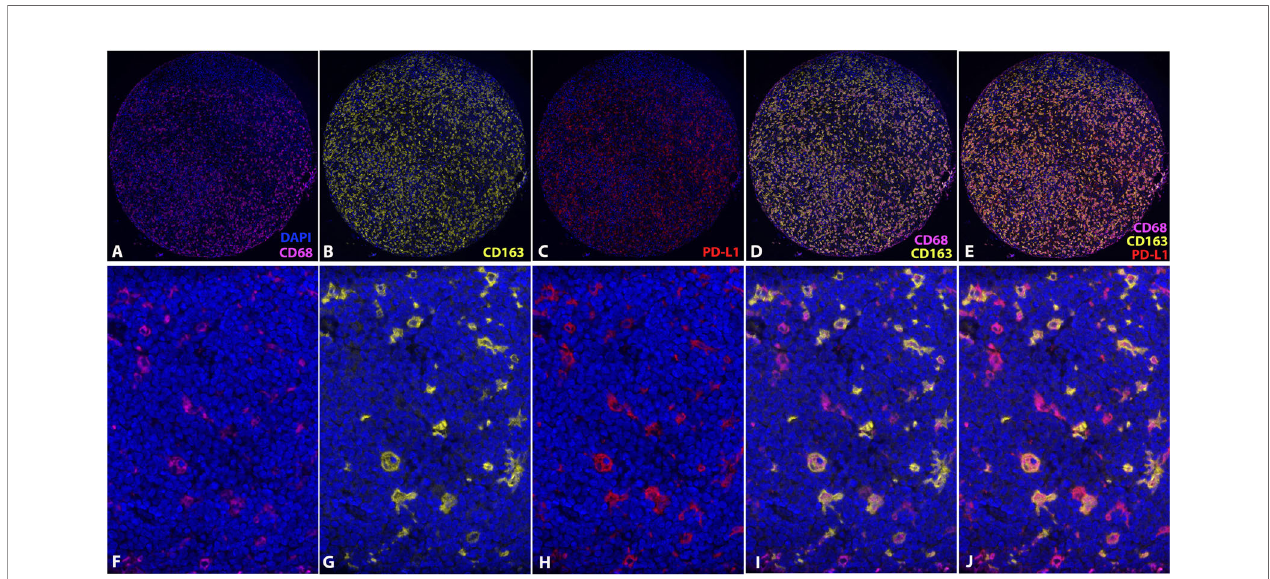
FIGURE 3 | Multiplexed quantitative immuno fl uorescence analysis. Immuno fl uorescence stains of CD68 (A, F) , CD163 (B, G) , and PD-L1 (C, H) . Overlying of CD68 and CD163 (D, I) . Overlying of CD68, CD163 and PD-L1 (E, J) . (DAPI, counterstaining of nuclei; CD68, Cy7; CD163, Cy3; PD-L1,